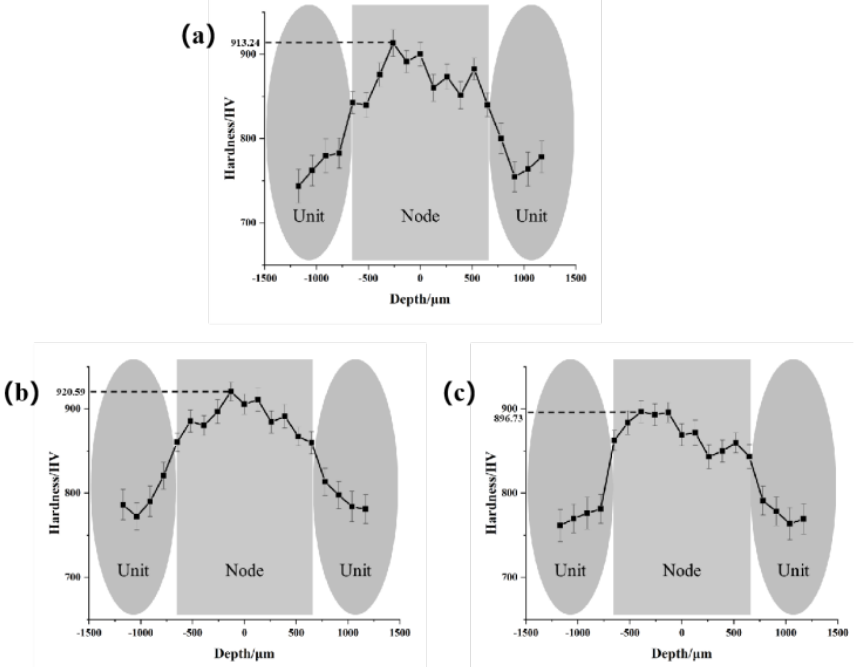
Figure 9. Vickers Microhardness at regions A and B: ( a ) 1.5 mm, ( b ) 2.5 mm, ( c ) 3.5 mm.